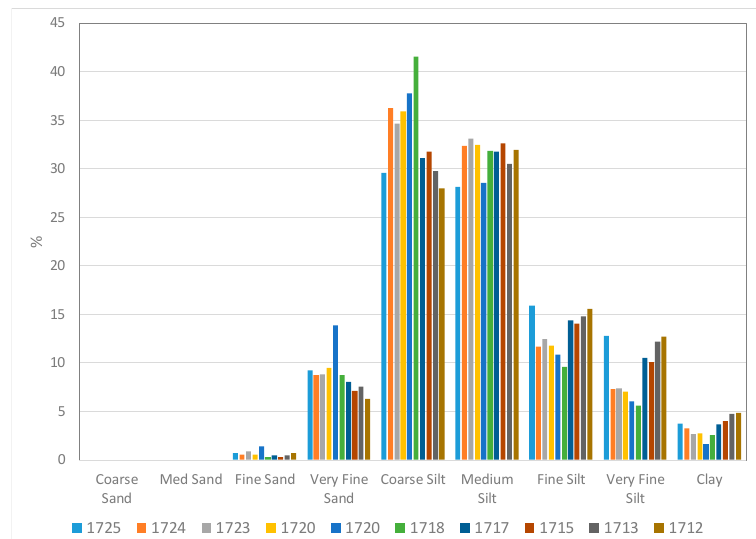
Figure 8. Grain size classes in the fine fraction ( < 63 µ m) of the samples from Lake Clover shorelines analyzed by laser scattering. Coarse silt and medium silt make up the largest proportion of these samples. Clay is relatively uncommon in the fine fraction ( < 5%). Samples are designated by their corresponding lake elevation, as shown in Table 1.